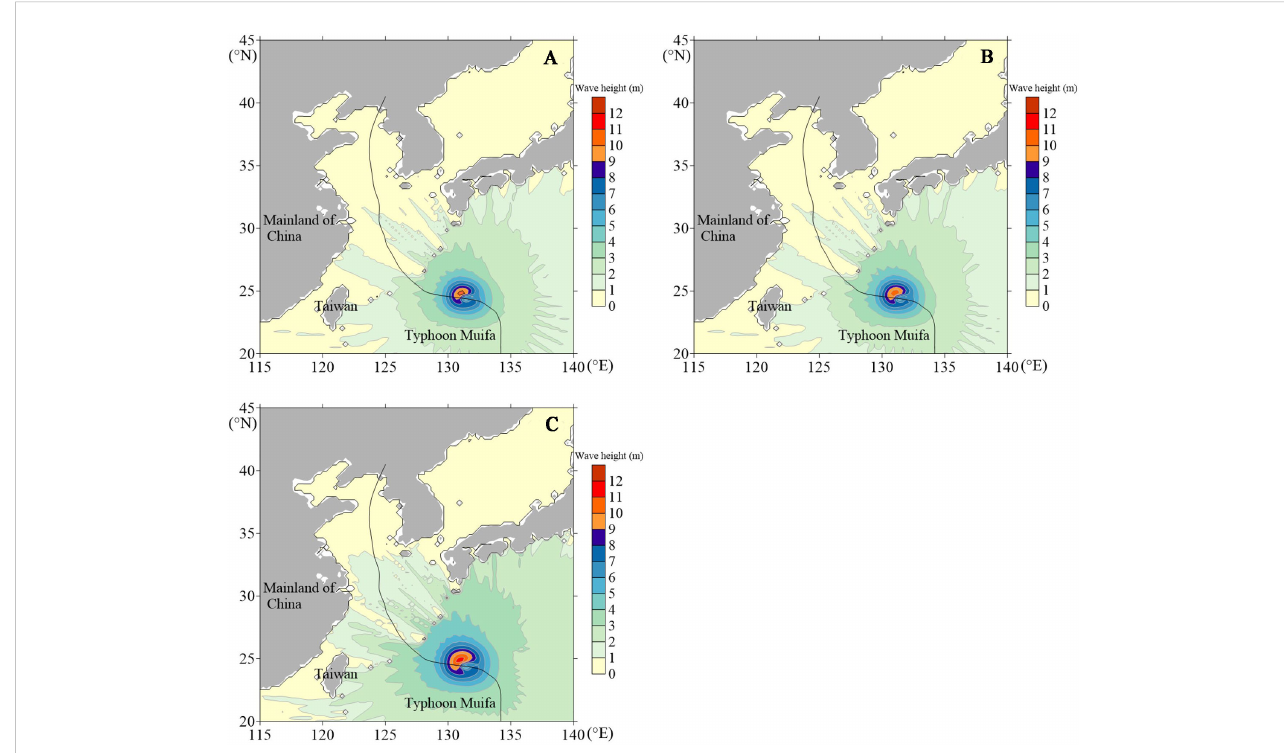
FIGURE 6 Distribution map of the wave fi eld of Typhoon Muifa at 1200 UTC 3 August 2011: (A) symmetrical wind fi eld, (B) superimposed wind fi eld, (C) asymmetric wind fi eld.